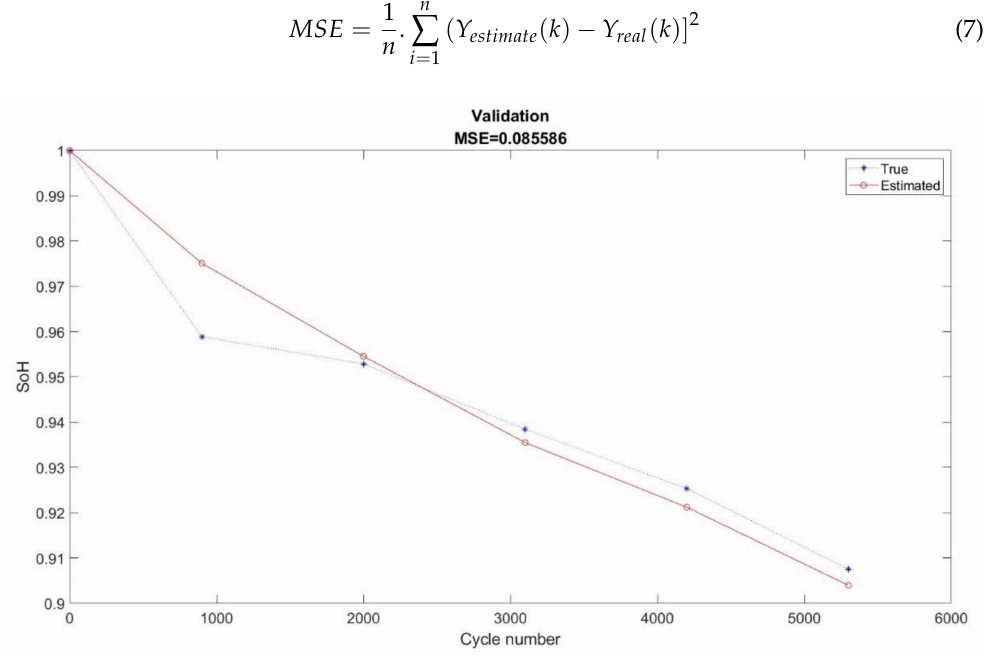
Figure 10. Validation for SoH estimation; of cell No. 24.